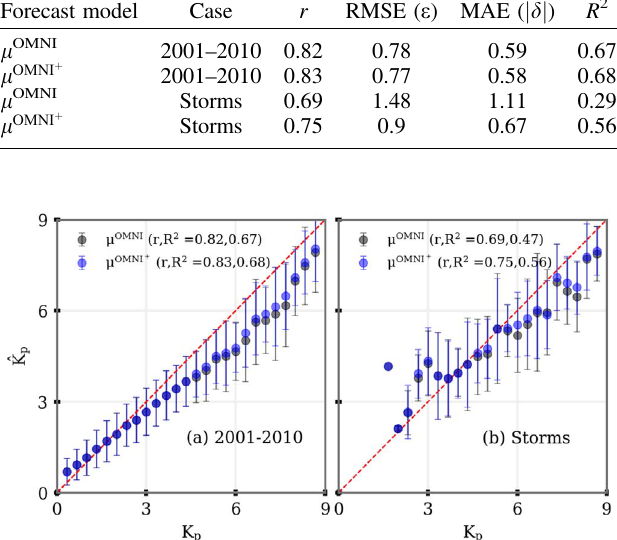
Fig. 8. The performance comparison of l OMNI and l OMNI þ models which predict K p 3-h ahead. Panels present performance of l OMNI (in black) and l OMNI þ (in blue) models for (a) 10 years of prediction and (b) 38 storm-time prediction (listed in the Table 3). In each panel of fi cial (Postdam) K p is plotted on the x -axis and the model prediction is plotted on the y -axis. Perfect predictions would lie on the line with a slope of one. The error bar indicates one standard deviation and the correlation coef fi cient and coef fi cient of determi- nation are mentioned inside each panel.